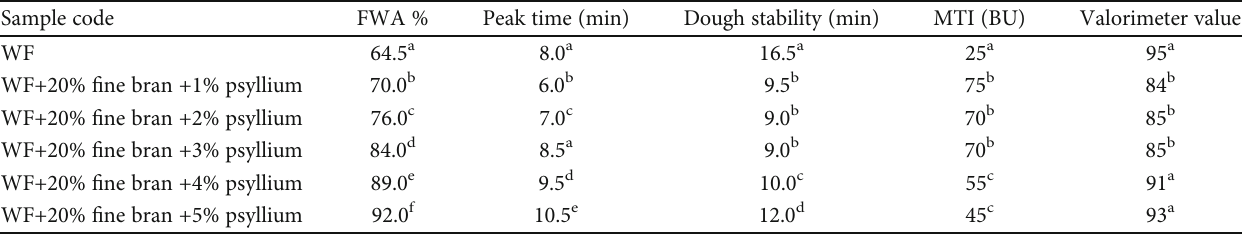
Table 4: Farinograph characteristics of dough made from fl our, fi ne bran, and psyllium blends.